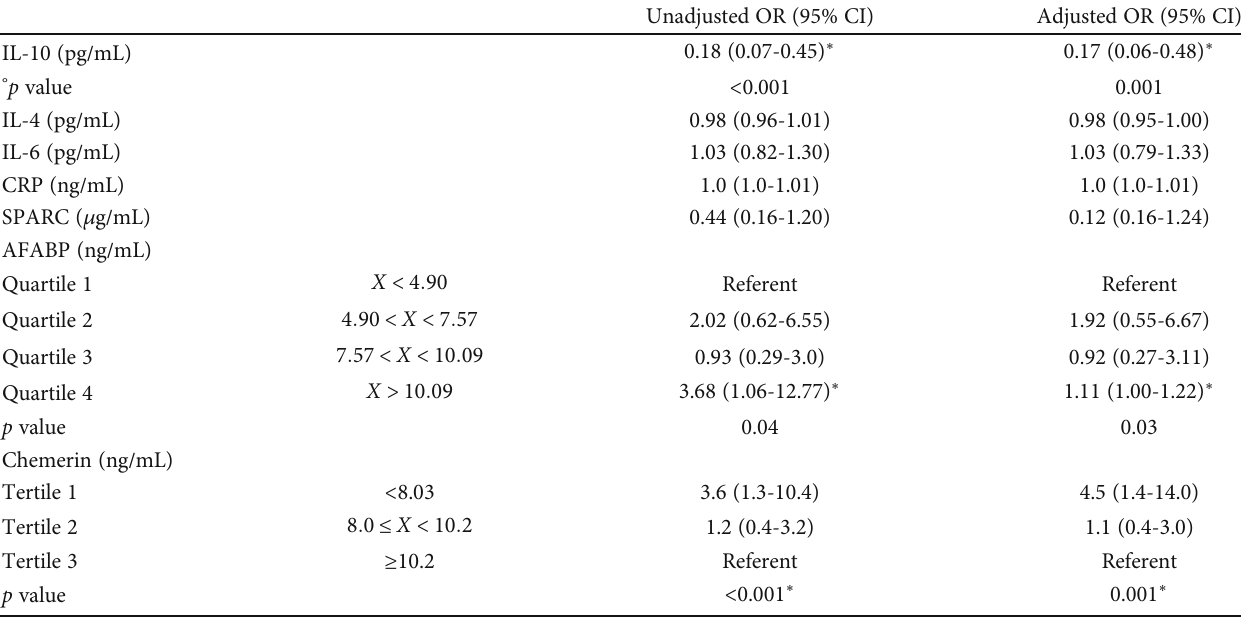
Table 2: Association between adipocytokines and GDM risk (24-28 weeks).